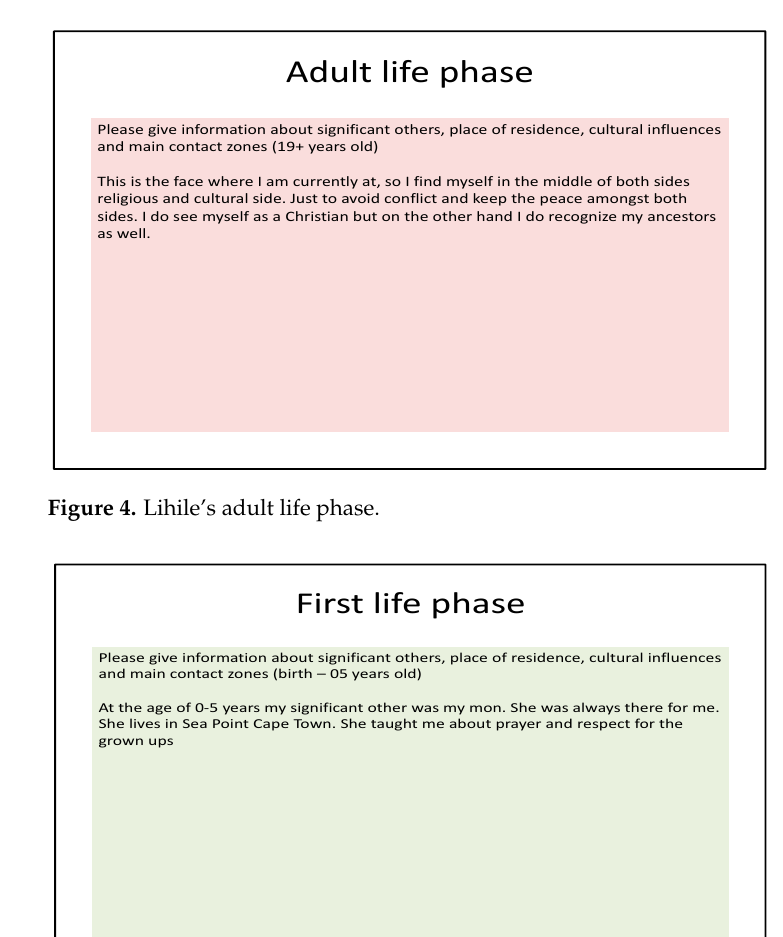
Figure 3. Lihile’s adolescent life phase.